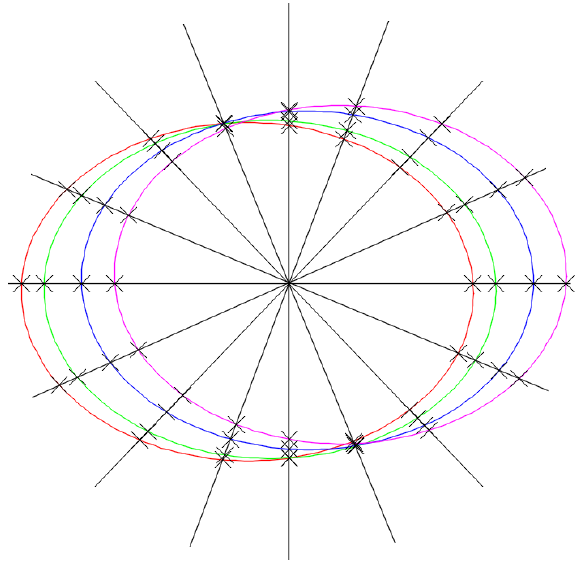
Figure 10. Framework (black lines) for identifying